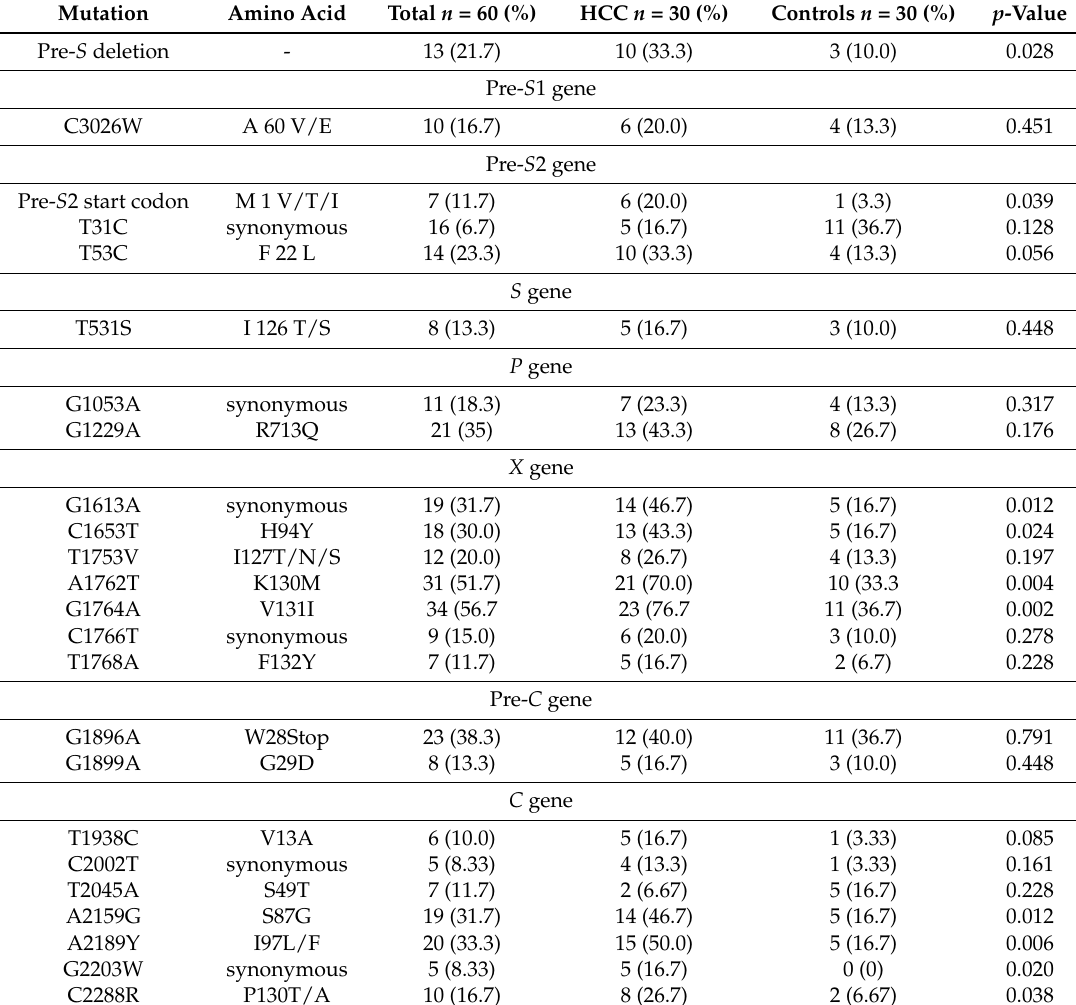
Table 2. The prevalence of hot-spot mutations throughout the complete HBV